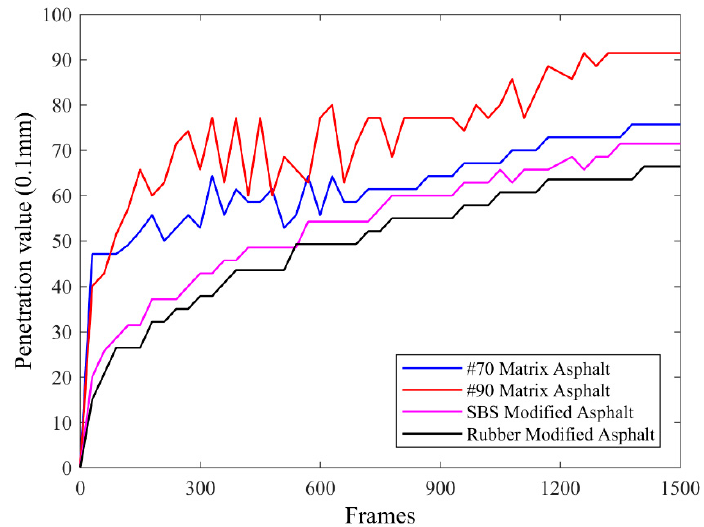
Figure 5. The relationship between the penetration value and the image frame number.